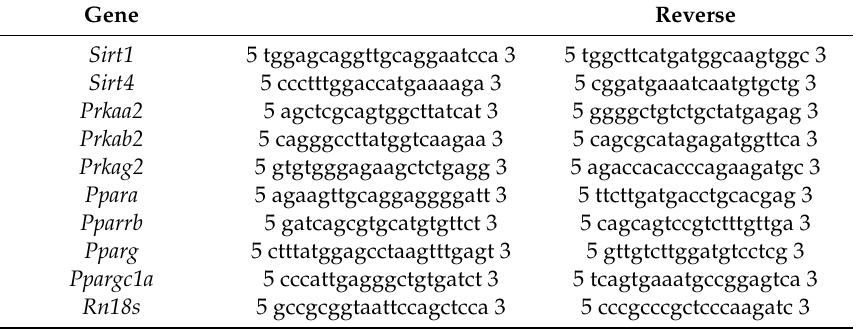
Table 1. Quantitative real-time polymerase chain reaction primers